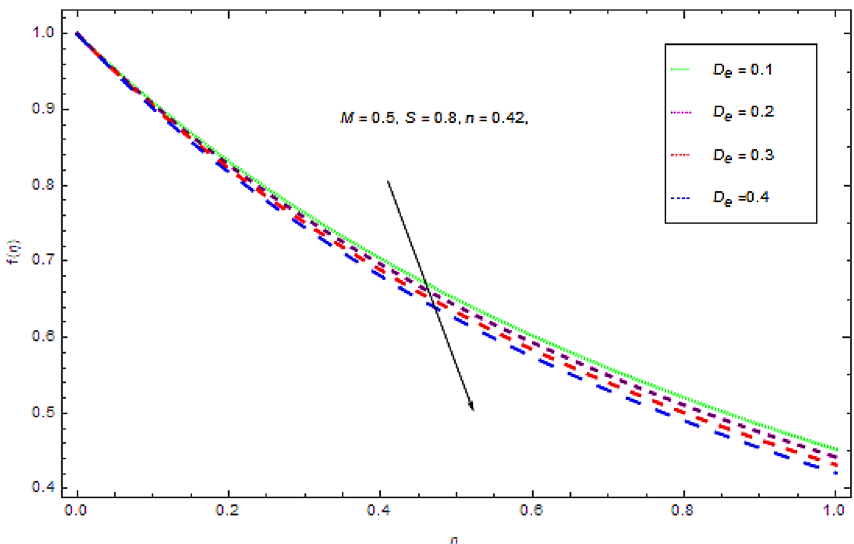
Figure 8. Influence of D e on f (η) .